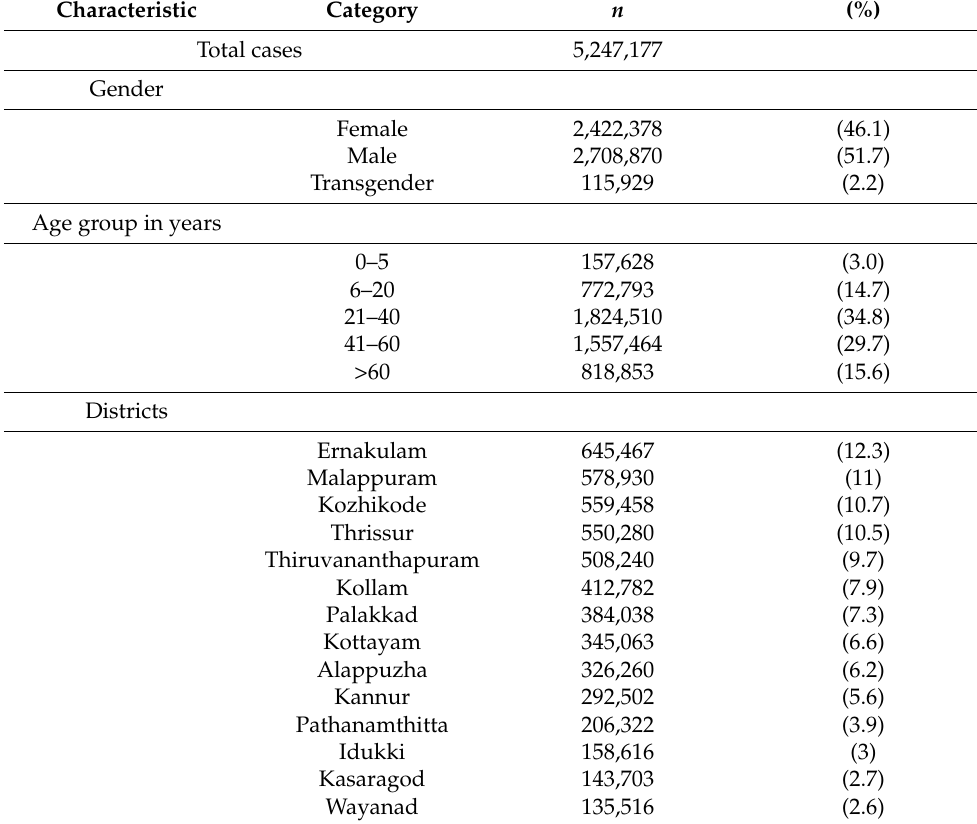
Table 1. Demographic characteristics and demographic distribution of COVID-19 patients in Kerala,